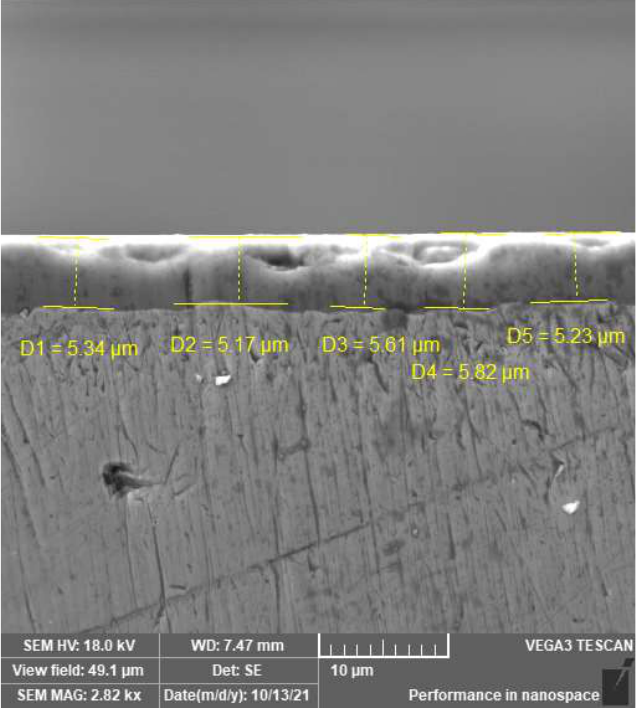
Figure 2. A cross section of a micro-coated sample with the measurement of its thickness.